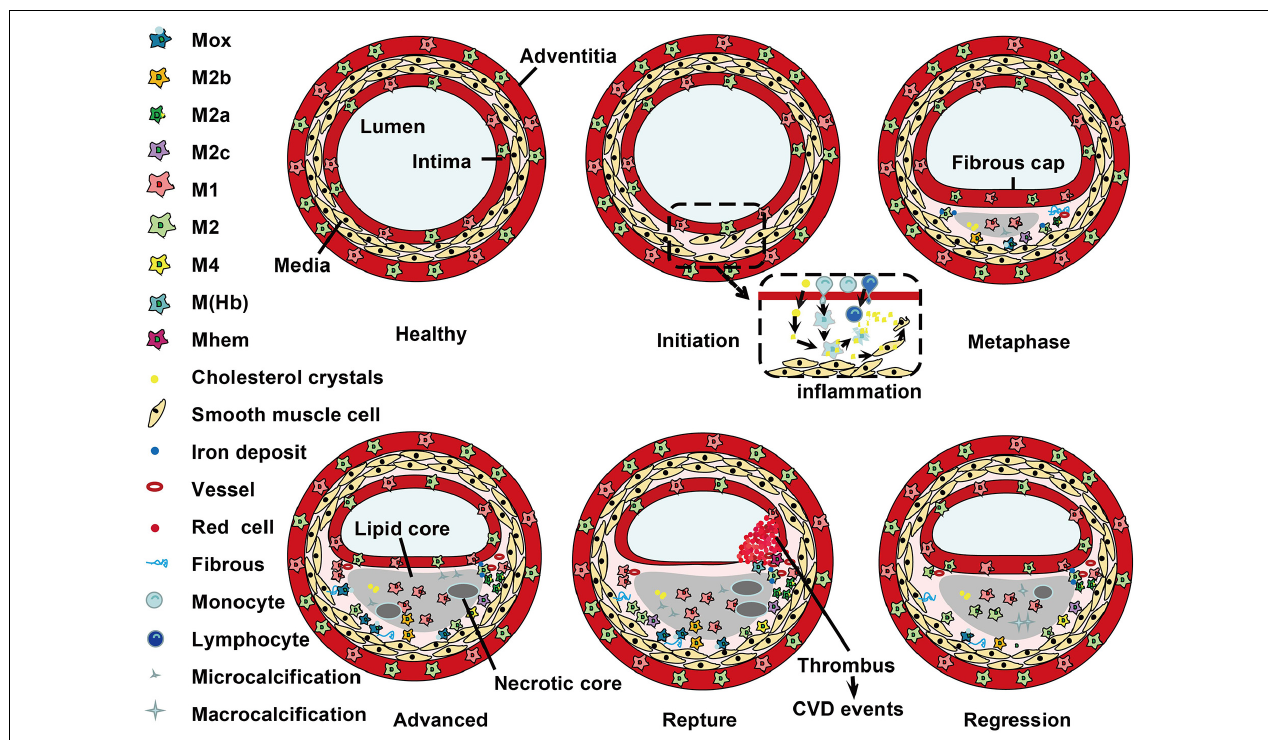
FIGURE 2 | Localization of macrophage subtypes in human atherosclerotic lesions. Atherosclerosis is initiated with a local inflammatory response and the presence of monocyte-derived macrophages. In the intima, macrophages (mainly M1 phenotype) scavenge lipoprotein particles and become foam cells. The secreta of foam cells and M1 macrophages promote lipoprotein retention and sustain inflammation, leading to a further M1 macrophage polarization during atherosclerosis progression. The cholesterol crystals deposited in the plaque can further promote M1 polarization. However, fibrous caps contain similar amounts of M1 and M2 macrophage. In advanced lesions, the gradual accumulation of apoptotic debris results in formation of a necrotic core, which triggers further inflammation and necrosis. Of note, M1 macrophages are predominantly found in the plaque shoulder and lipid core, whereas M2 macrophages localized in the adventitia and areas of neovascularization or outside the lipid core. The degradation of the extracellular matrix and cycles accumulation of lipids may induce plaque rupture and the following thrombosis. In vulnerable plaques, the number of M1 macrophages is increased, while the number of M2 type macrophages is decreased. It is worth noted that M2 macrophages can phagocytose apoptotic M1 macrophages, contributing to the resolution of inflammation. In regressing plaques, there are more M2 macrophages than M1 type